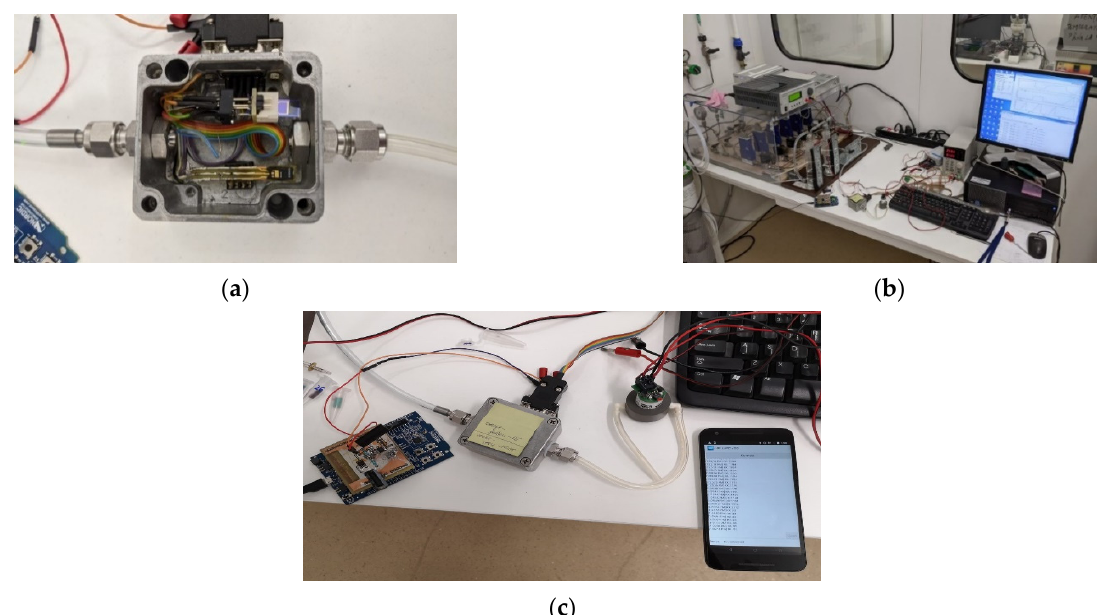
Figure 12. ( a ) Test chamber in which the sensor is placed to expose the known CO gas concentrations; ( b ) laboratory setup used to test the sensor’s correct operation and also to verify our portable readout electronics; ( c ) readout module connected to the sensor in the test chamber, with a smartphone wireless connection established for data logging.